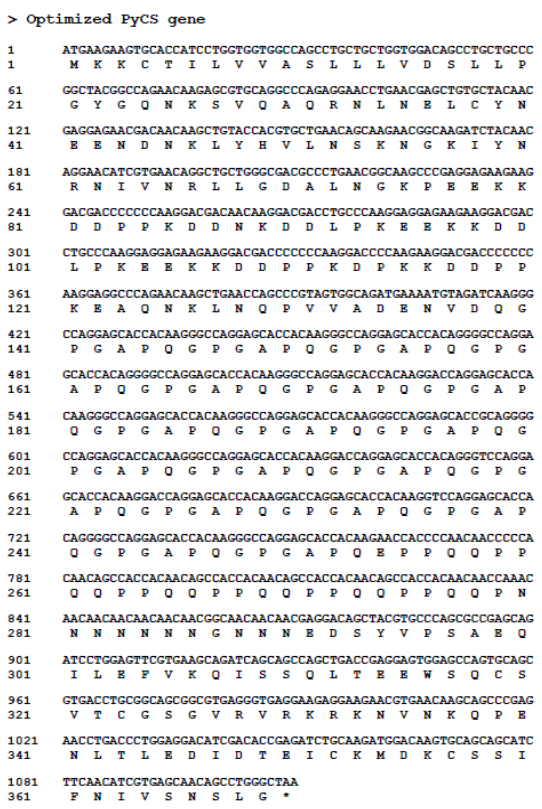
Figure 1. Codon optimized sequences of PyCS and